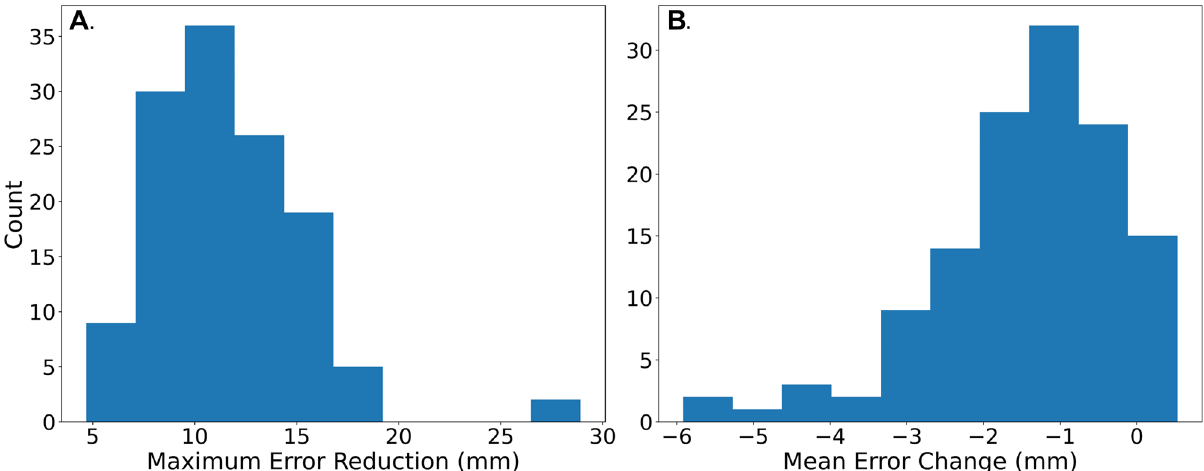
Figure 3. Application of DisCo leads to reduction in anatomic error of DWI. ( A ) Maximum error reduction was taken for each subject in our sample and plotted in a histogram. ( B ) Mean change in error before and after application of DisCo. DisCo distortion correction.